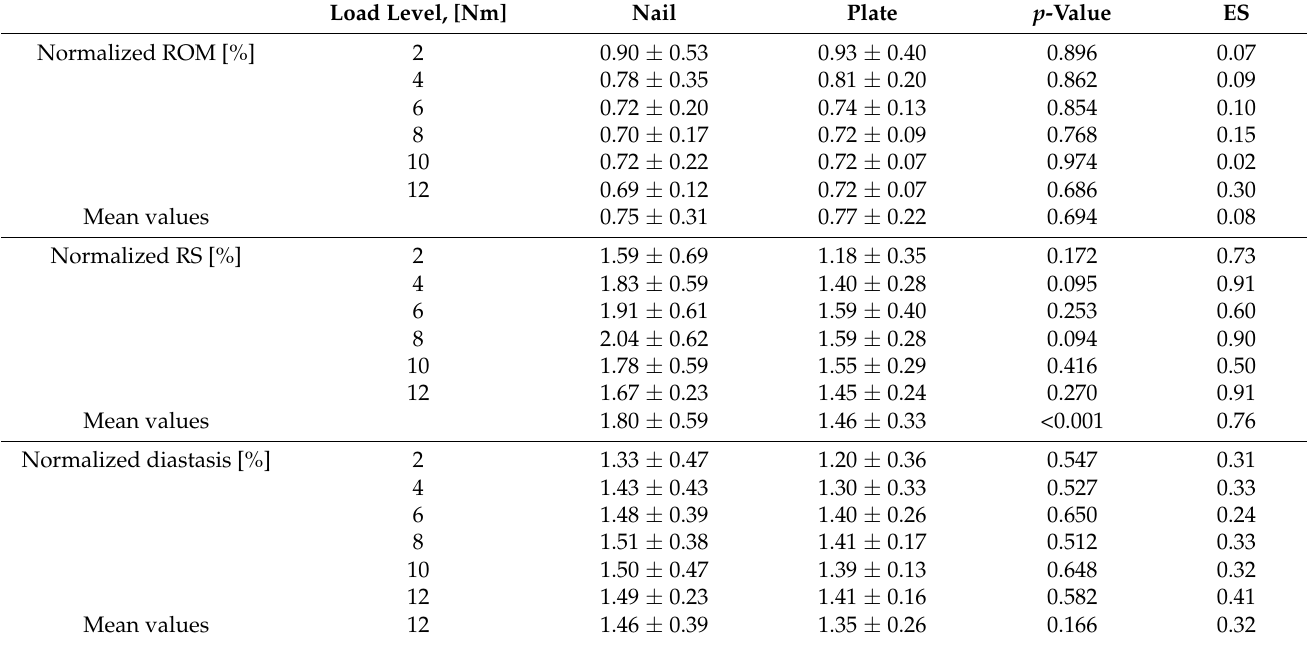
Table 1. Results of the biomechanical tests of the nail and plate fixations for each load level, nor- malized to the native condition. Values greater than 1 indicate greater movement (range of motion (ROM) and diastasis) or stiffness; lower values vice versa. To compare both stabilization methods, the normalized values of ROM, RS, and diastasis were used in separate GLMs with the group as the fixed factor, respectively. The p -values and effect size (ES, Cohen’s d) are presented for each pairwise comparison and for the mean values of all force levels. The significance level was set at ≤ 0.05. The ES values as Cohen’s d mean: 0.2 = small effect, 0.5 = medium effect, 0.8 = large effect. Load Level, [Nm] Nail Plate p -Value